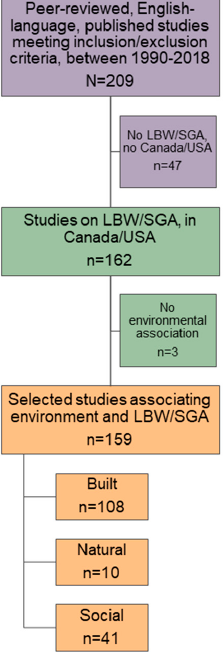
Figure 5. Flow diagram documenting the selection of published studies within Canada and the USA, between 1990 and 2018, for examining associations of the outdoor environment with low birth weight (LBW), birth weight (BW), and small for gestational age (SGA).